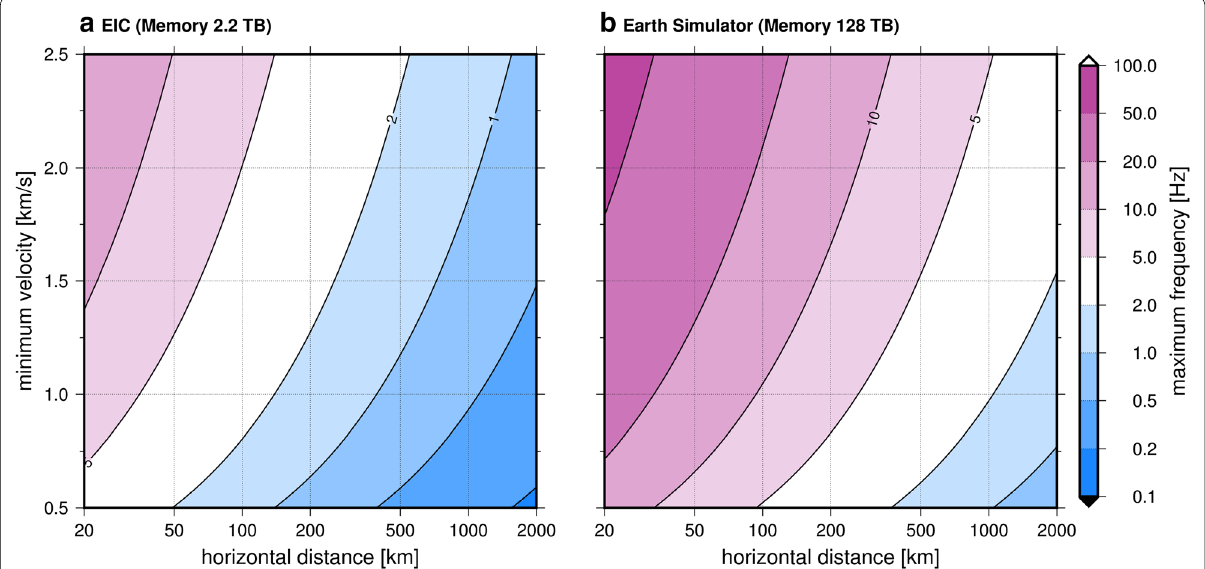
Fig. 9 Maximum frequency of the 3D FDM simulation bounded by the maximum memory size for a the EIC computer (2.2 TB) and b the Earth Simulator (128 TB) as a function of the horizontal size of the 3D model and the minimum value of the wavespeed in the medium. The color scale is shown in the